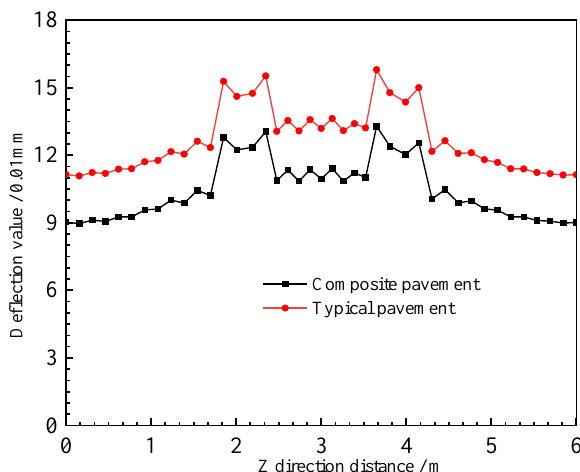
Figure 20. Deflections of the two pavement structures.